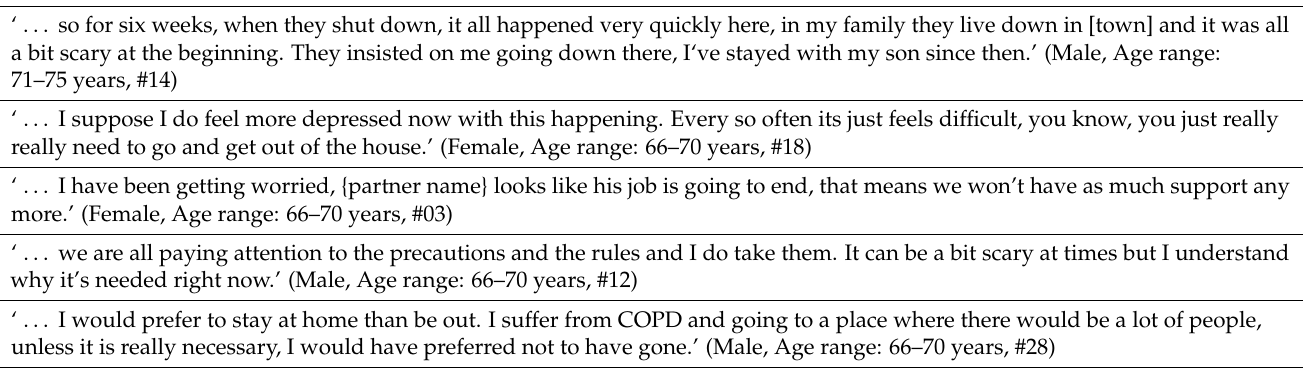
Table 3. Selected quotes related to views on the influence of COVID-19 on social and personal